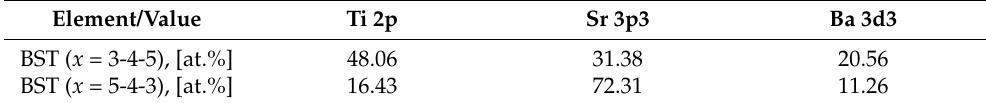
Table 7. Atomic concentration table according to the results of the XPS survey spectrum measurement.